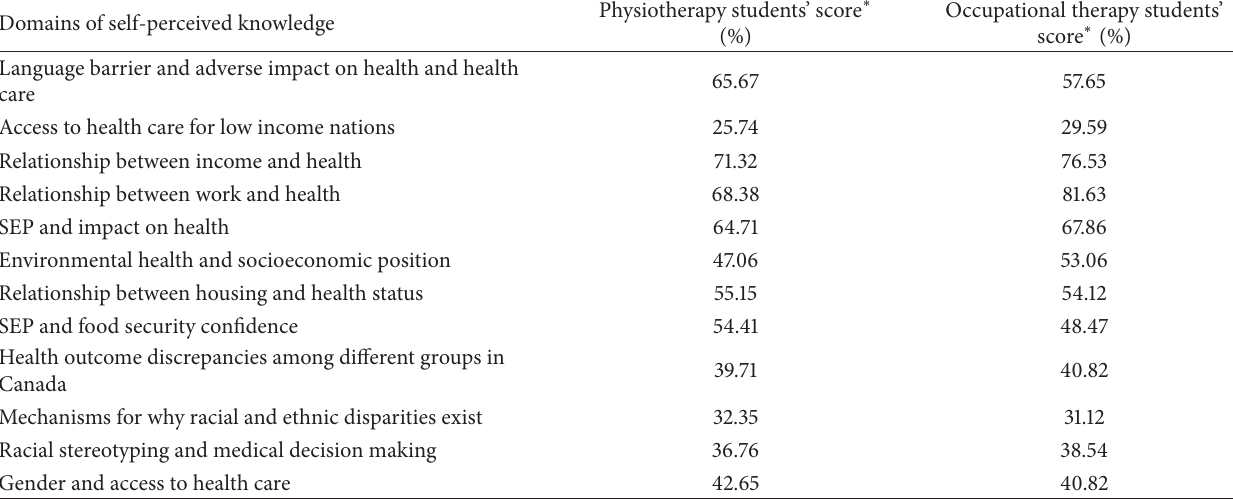
Table 2: Physiotherapy and occupational therapy students’ self-perceived knowledge in global